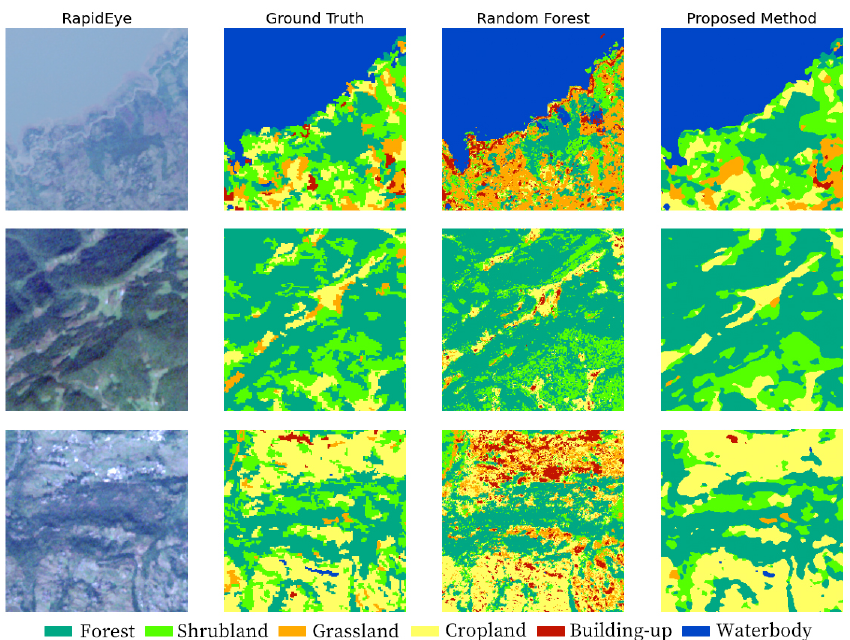
Figure 11. Comparison of random forest and proposed model outputs. The first column shows the RGB image, the second column shows the ground truth label, the third column shows the classification results from Random forest, and the fourth column shows the classification results from proposed